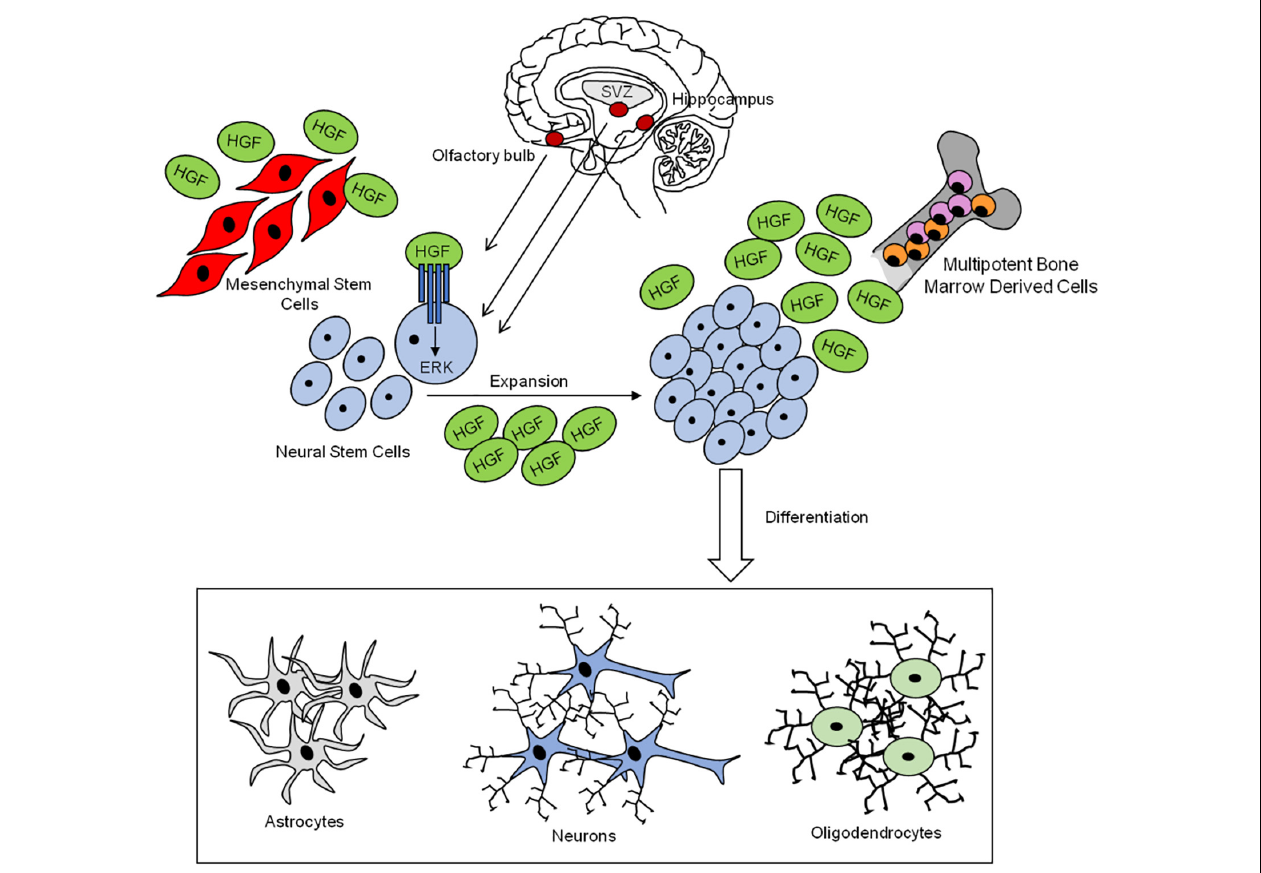
FIGURE 6 | Neural stem cells contribute to nervous system cell regeneration. HGF-MET pair drives the mobilization, expansion, and differentiation of neural stem cells into the three main nervous system cells: astrocytes, neurons, and oligodendrocytes. HGF is secreted by bone marrow-derived stem cells and mesenchymal stem